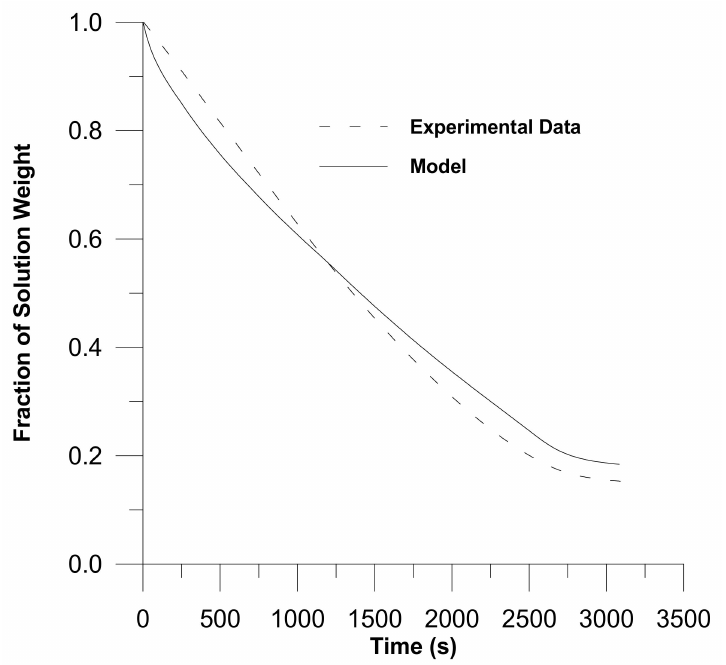
Figure 3. Non-Fickian diffusion for the system poly(methyl methacrylate)/ethyl benzene. Fraction of solution weight as a function of evaporation time. Initial ethyl benzene weight fraction: 0.9014,